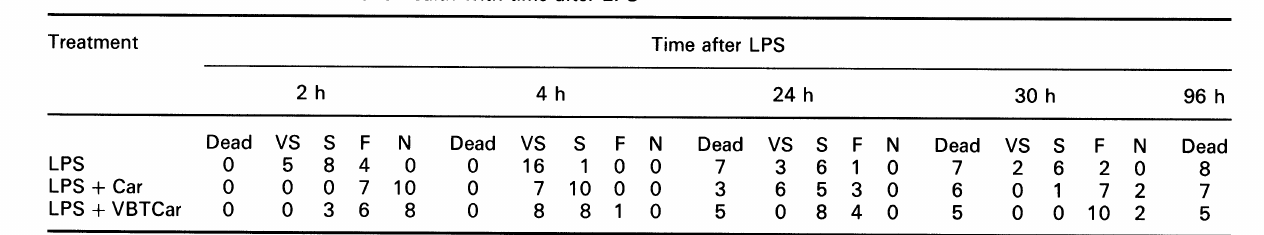
Table 2. The variation of food consumption with time